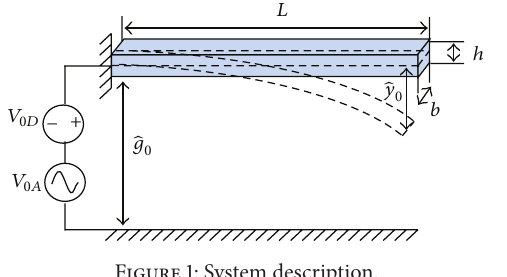
Figure 1: System